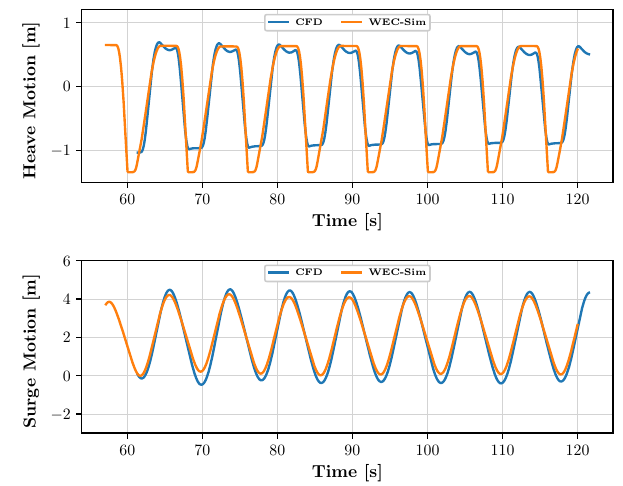
Fig. 8. The WEC is restricted to move only in heave and surge direction (2 DoF case). The upper plot represents the time series of heave motion, and the lower plot shows the surge motion.